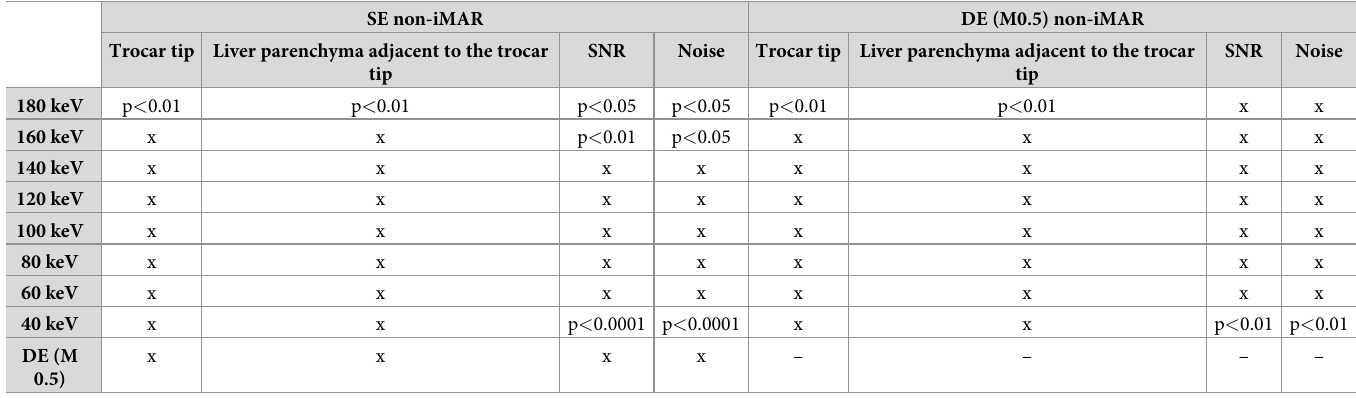
Table 1. Crosstable for p-values based on HU measurements at the trocar tip and liver parenchyma adjacent to the trocar tip, SNR and noise on axial images with VMSI, SE I30-3 and DE Q30-3 without iMAR. SE non-iMAR DE (M0.5) non-iMAR SNR Noise Trocar tip Liver parenchyma adjacent to the trocar SNR Trocar tip Liver parenchyma adjacent to the trocar tip tip